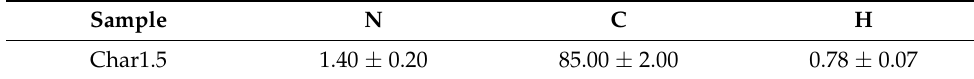
Table 4. Elemental analysis of Char1.5.